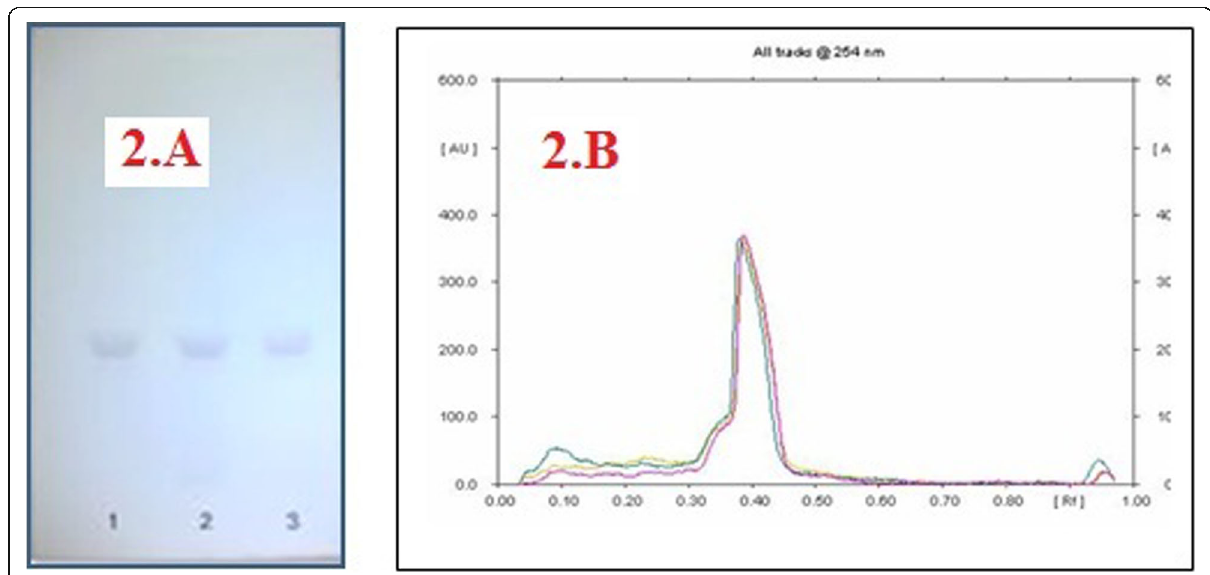
Fig. 2 a Co-chromatography of embelin with test sample (1) and reference std (2 and 3) and b HPTLC chromatogram of reference standard (pink) and isolated embelin (green and